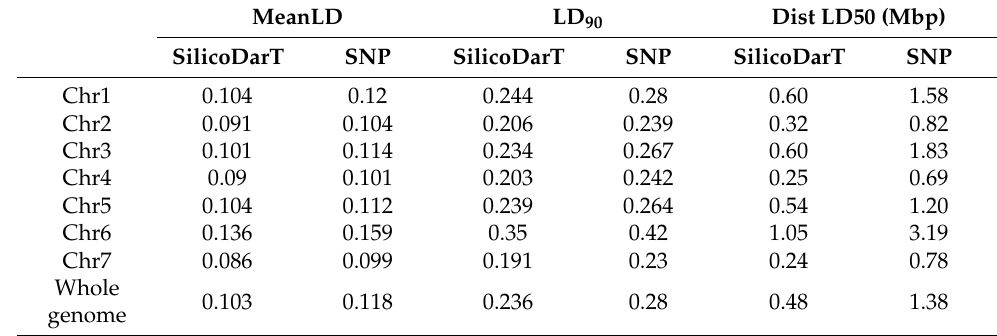
Table 4 . Critical values of LD and LD-decay distance estimated for the DArTSeq markers.